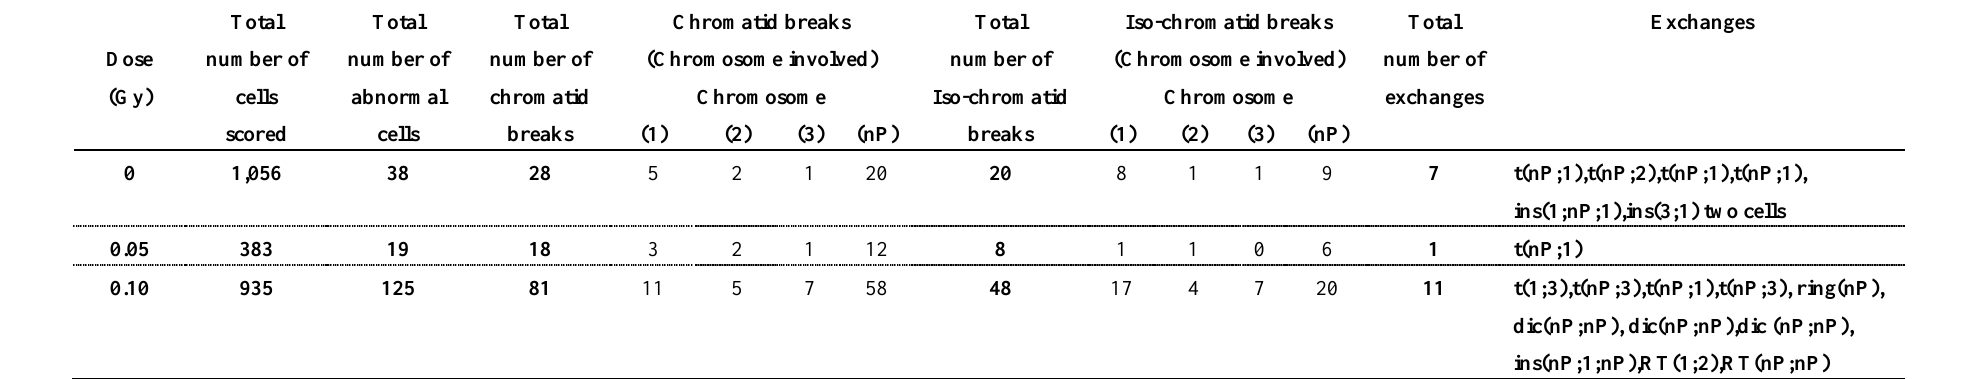
Table 2. Cytogenetic data from bone marrow cells collected at 4 h after exposure of male SCID/J mice to varying low doses of 137 Cs  rays, including a high dose of 1.0 Gy serving as a reference dose. All aberrations are chromatid-types. t Translocation (incomplete chromatid-type), RT Robertsonian translocation, dic Dicentric, ins Insertion, nP Non-painted chromosome. Total